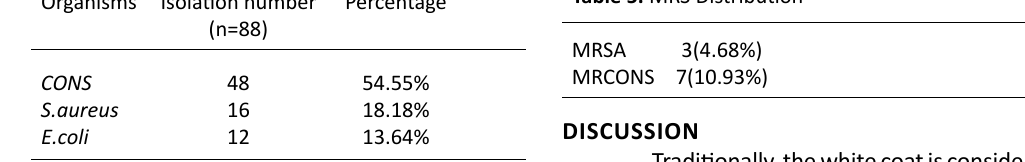
table 5. MRS Distribution